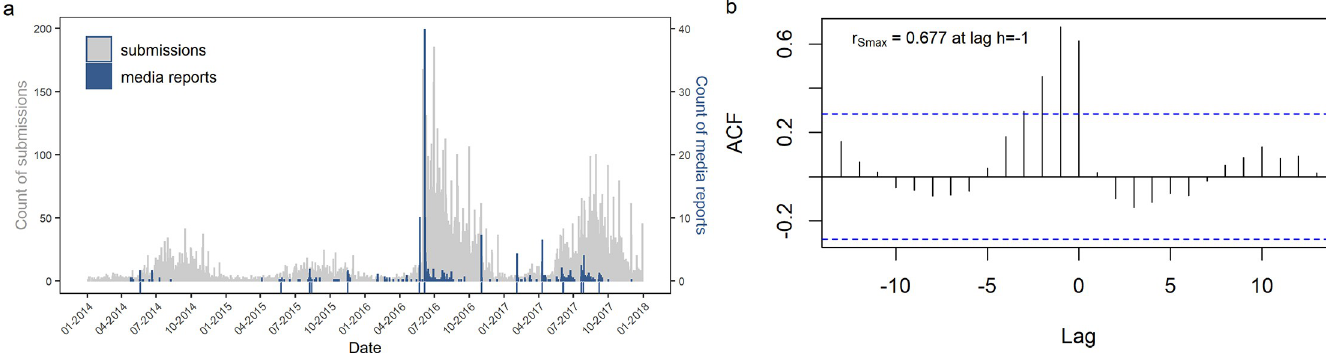
Fig 1. Temporal correlation of submissions of media reports between 2014 and 2017. (a) Combined plot of numbers of media reports (right y-axis) and submissions (left y-axis). The blue coloured ticks on the x-axis represent the dates of releases by the dpa regional studio Berlin-Brandenburg. Note the media echo and submission response to the dpa-release on June 6, 2016. (b) Cross-correlation analysis shows the highest value at -1, the blue dashed lines indicate a confidence threshold for α = 0.05.